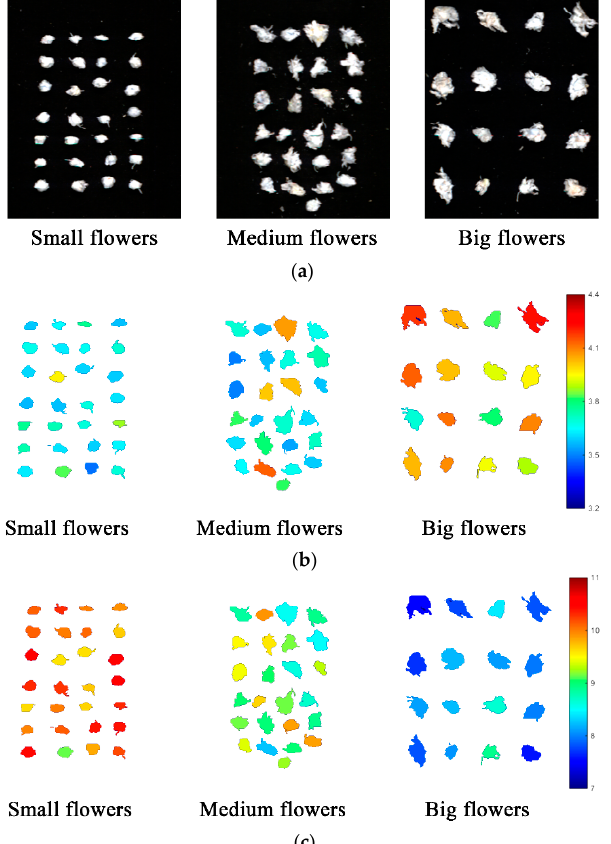
Figure 3. Prediction maps of total polysaccharides content and total flavonoids content in Chrysanthemum morifolium : ( a ) pseudocolor images; ( b ) prediction maps of total polysaccharides content; ( c ) prediction maps of total flavonoids